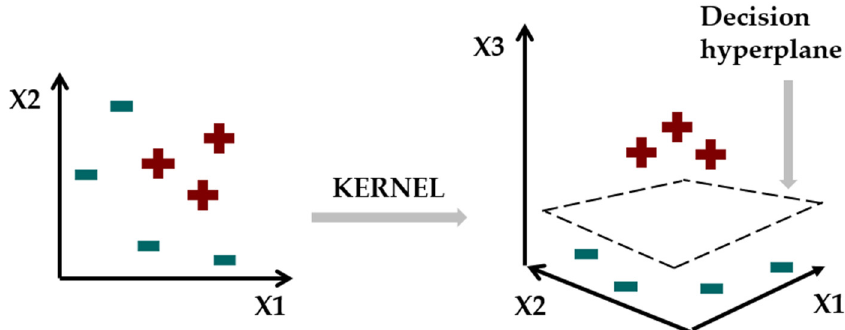
Figure 3. Illustration of transformation of the n-dimensional space into n + 1 dimensional space using a kernel function (there are examples of two classes – the first one consist of red pluses and the second one consist of green minuses).